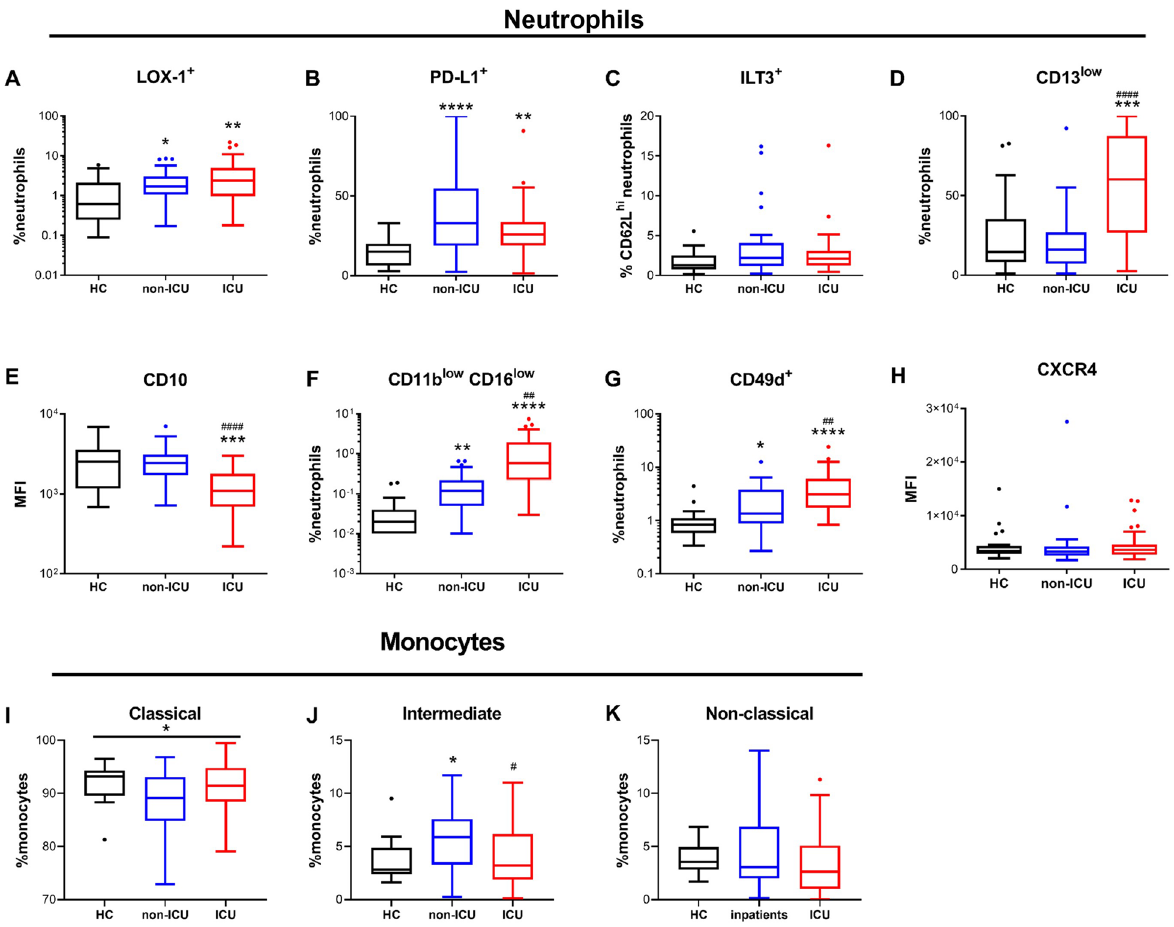
Figure 2. Neutrophil and monocyte subpopulations are disturbed in COVID-19 patients. ( A – H ) Percentages of positive cells and surface expression of markers related to subpopulations in neutrophils by flow cytometry. ( A ) LOX-1 + neutrophils, ( B ), PD-L1 + neutrophils, ( C ) ILT3 + CD62L + neutrophils, ( D ) CD13 low neutrophils, ( E ) CD10 expression on neutrophils, ( F ) CD11b low CD16 low neutrophils, ( G ) CD49 + neutrophils, ( H ) HLA-DR expression on neutrophils. ( I – K ) Percentages of monocytes subpopulations by flow cytometry. ( I ) CD14 + CD16- classical monocytes, ( J ) CD14 + CD16 + intermediate monocytes, ( K ) CD14 low/- CD16 + atypical monocytes. Intergroup comparison by Mann–Whitney U test between healthy controls and ICU or non-ICU patients: ****P < 0.0001, ***P < 0.001, **P < 0.01, *P < 0.05, between non-ICU and ICU patients: #### P < 0.0001, ### P < 0.001, ## P < 0.01, # P < .05. All boxplots whiskers represent 10th and 90th percentiles. HC healthy